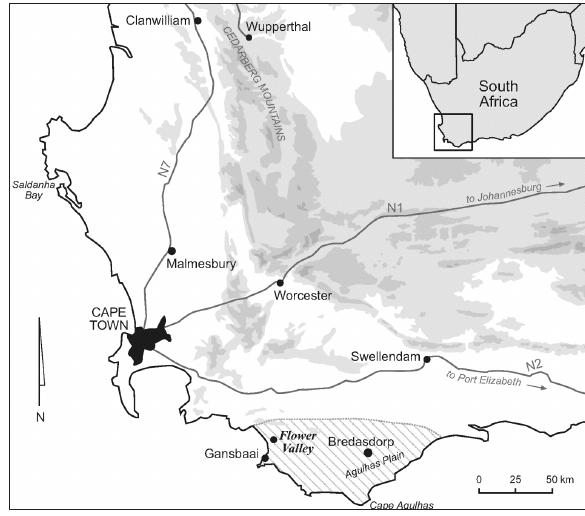
Figure 2: Map showing the location of the Agulhas Plain.